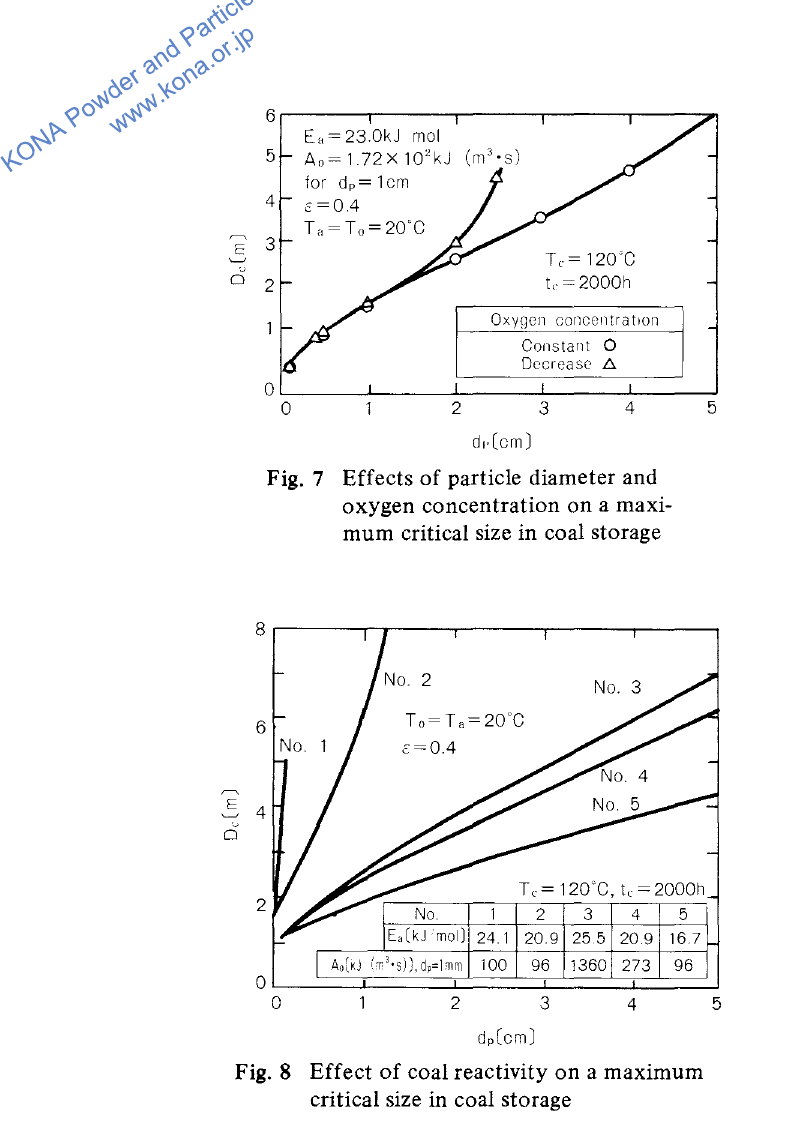
Fig. 7 Effects of particle diameter and